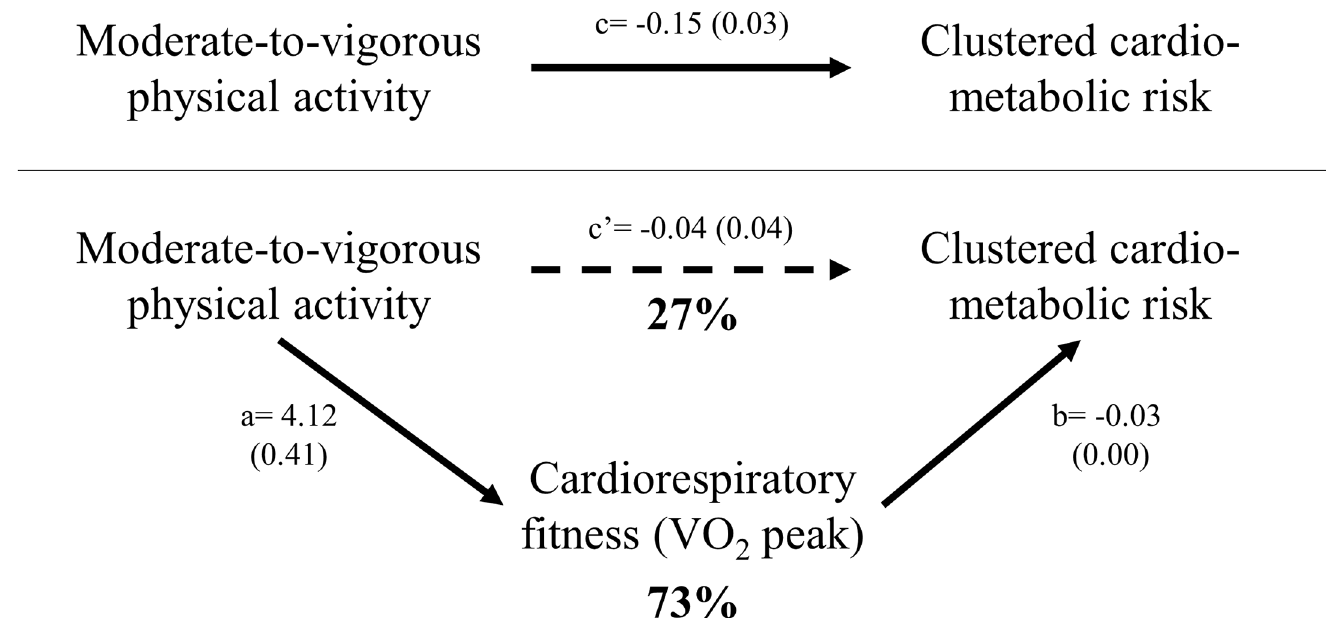
Fig 1. Mediation pathway of cardiorespiratory fitness. Pathway (regression coefficient of unstandardized exposures and outcomes (standard error)) of the association between moderate-to-vigorous physical activity (MVPA, hours/day) and clustered cardio-metabolic risk (CMRS) through cardiorespiratory fitness (CRF, ml.min -1 .kg -1 ) corrected for all covariates: sedentary time, age, sex, waking time, smoking, alcohol consumption, suger intake, saturated fat intake and education level. CRF explains 73% of the total variance in